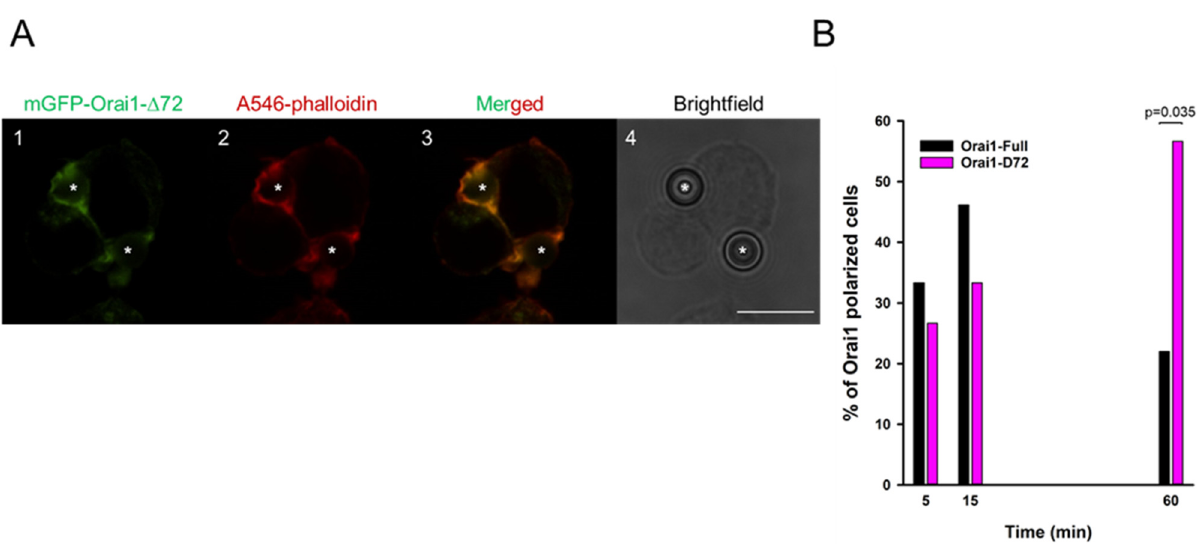
Figure 5. The mGFP-Orai1- ∆ 72 are retained in the IS. Confocal snapshots of the immune synapse formed between Jurkat cells expressing mGFP-tagged Orai1- ∆ 72 channel and CD3-CD28 antibody coated beads. ( A1 ) mGFP-tagged Orai1- ∆ 72 channel (green). ( A2 ) Alexa-546 phalloidin (red) as an IS marker. ( A3 ) Merged image of Orai1 (green) and Alexa-546 phalloidin (red) fluorescence signals. ( A4 ) Brightfield image of the mGFP-Orai1- ∆ 72 channel expressing cell show in Aa-Ac. The bead is indicated with an asterisk. Scale bar is 10 µm. ( B ) The percentage of cells showing the Orai1 polarization in mGFP-Orai1-Full (black, same data shown in Figure 1B) and in mGFP-Orai1- ∆ 72 (pink) expressing cells at 5th, 15th and 60th minute. 30 cells were evaluated at each time point.